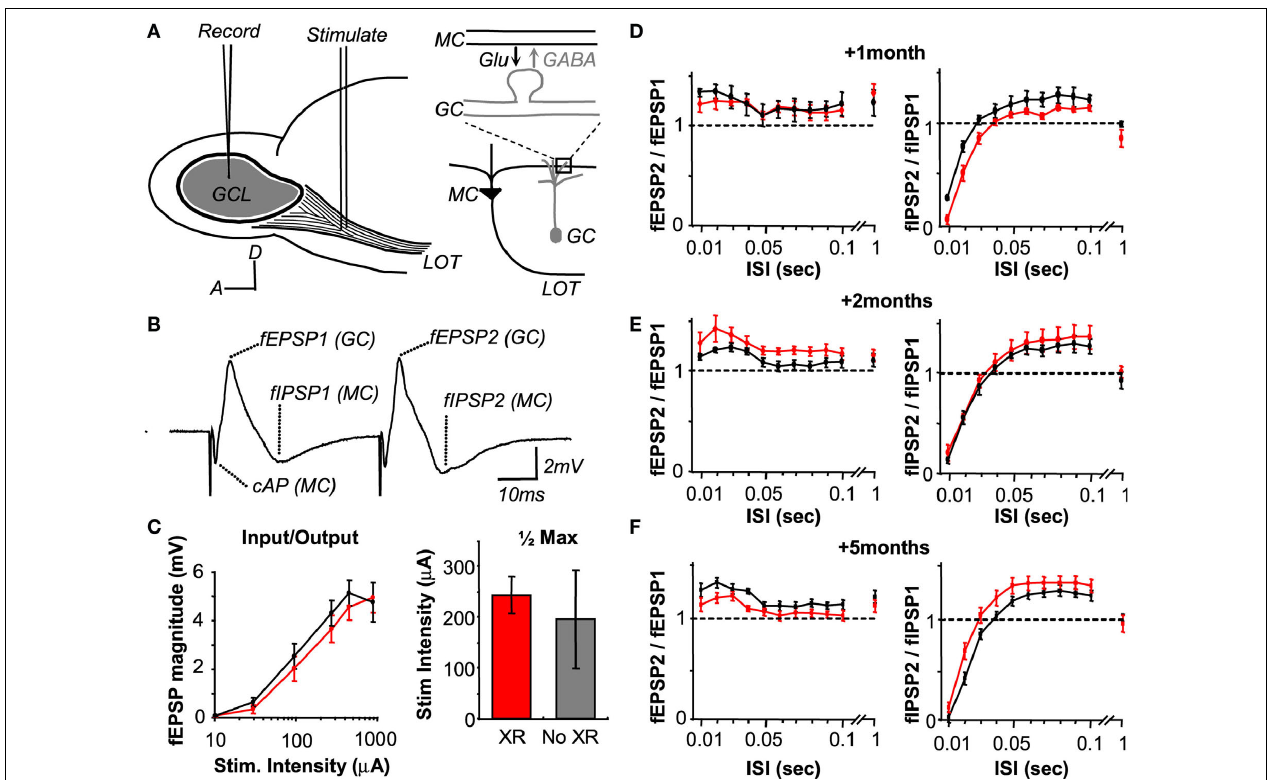
FIGURE 5 | Loss of neurogenesis does not change the activation and plasticity of the dendro-dendritic synapse in-vivo . (A) Schematic of the stimulation paradigm, with a diagram of the dendro-dendritic circuit between mitral cells (MC) and granule cells (GC). (B) The waveform following stimulation has three distinct phases corresponding to the mitral cell compound action potential (cAP), the fi eld EPSP (fEPSP) originating in the granule cells, and the reciprocal fi eld IPSP (fIPSP) in mitral cells.